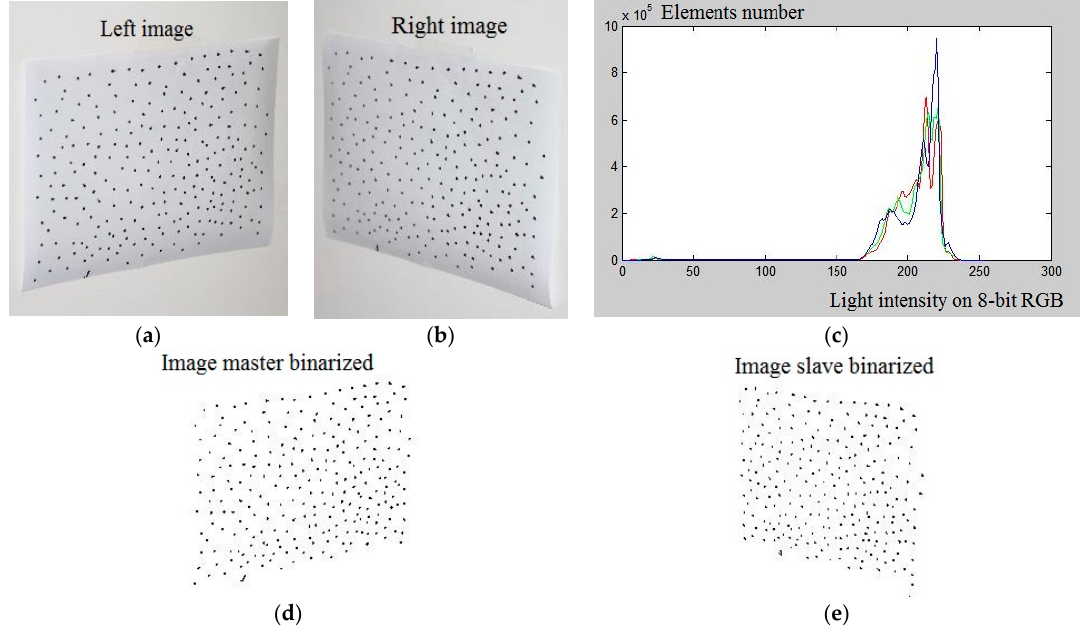
Figure 3. (a , b ) Software, loading of the “right” and “left” images and their display. ( c ) image analysis, chromatic distribution and level filter, the curves represent the three colors RGB (red, green, blue). ( d , e ) Image binarized.